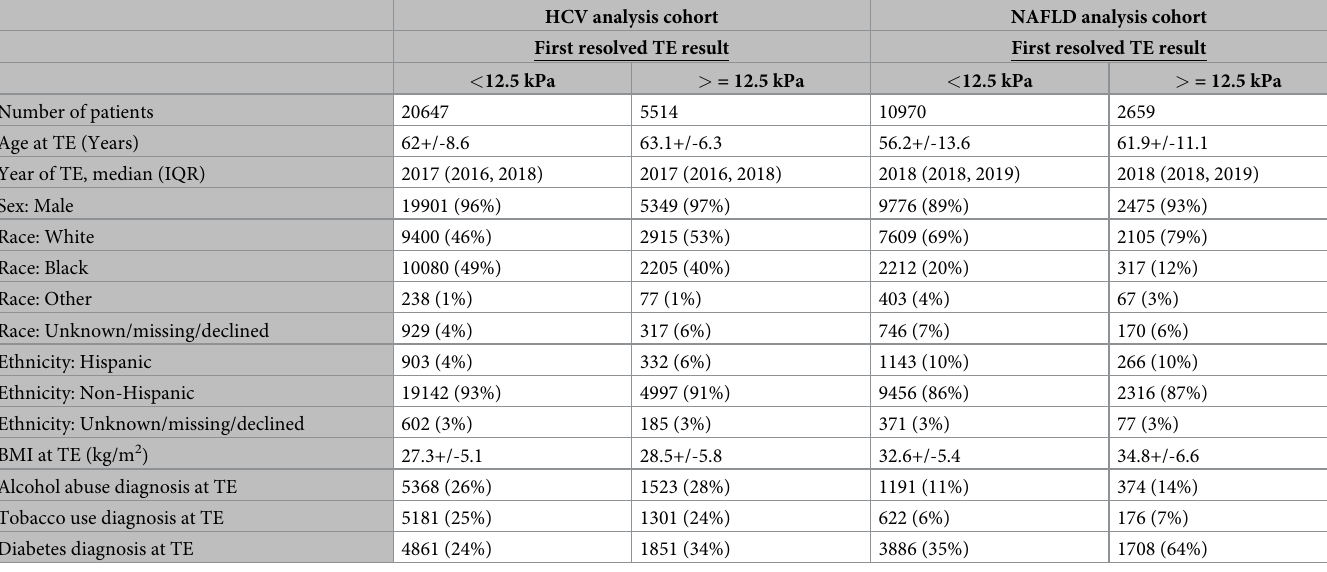
Table 1. Baseline characteristics of the patient populations in HCV and NAFLD analysis populations, categorized by first resolved TE result.